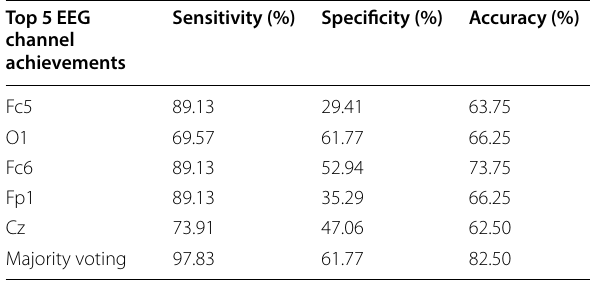
Table 3 Top 5 EEG channel achievements on beta rhythm for HV vs LV classification